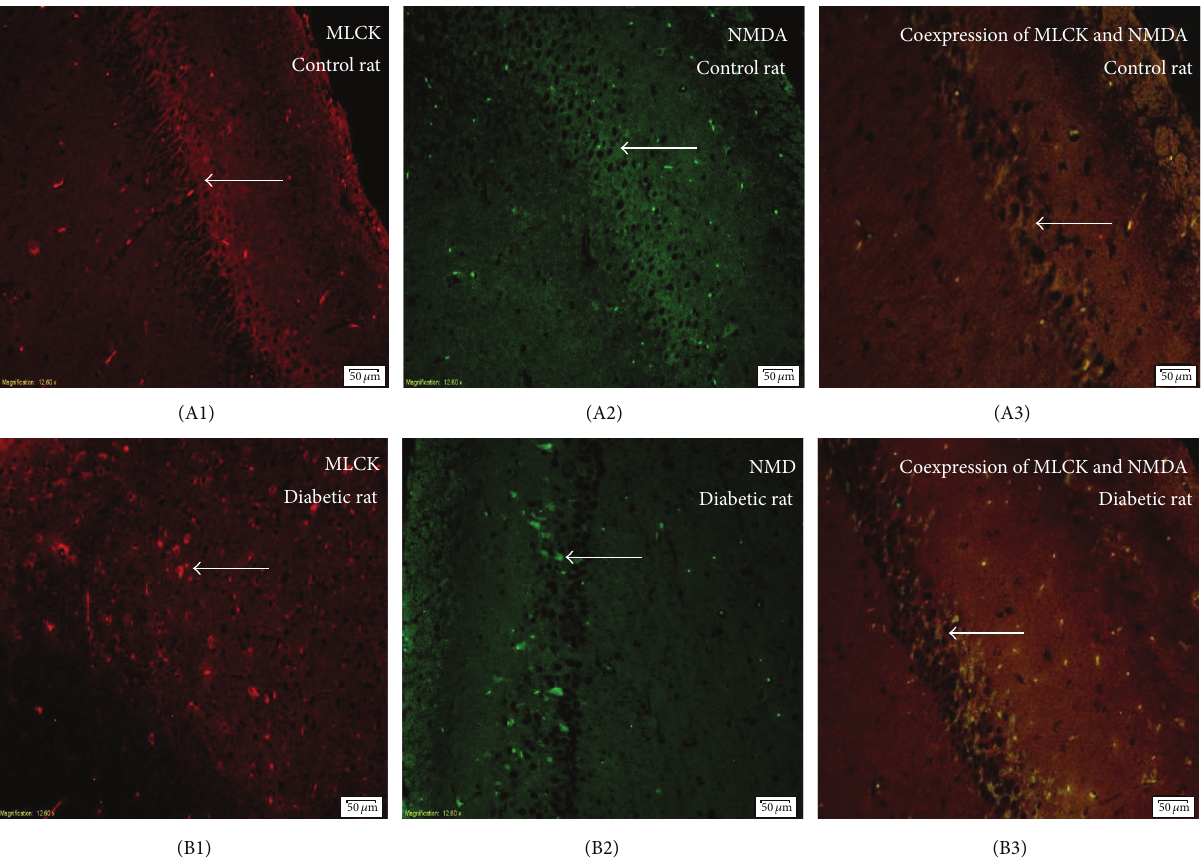
Figure 2: The representative photos of MLCK (red light) and NMDAR2B (green light) expressions in hippocampal tissue in rats by immunofluorescence staining. The coexpression of MLCK and NMDAR2B was shown as yellow light. (A1)–(A3), control rats; (B1)–(B3), diabetic rats. Immunofluorescence staining showed that the expression of MLCK and the NMDA receptor and their coexpression in the rats hippocampus in diabetic rats (group B) were significantly higher than rats in control rats (group A) ( 𝑃 < 0.05 ) (Figure 2, Supplementary Table 1). According to the Person correlation analysis, the expression of MLCK and NMDAR2B showed a positive correlation ( 𝑟 = 0.958 , 𝑃 < 0.01 ) (Supplementary Figure